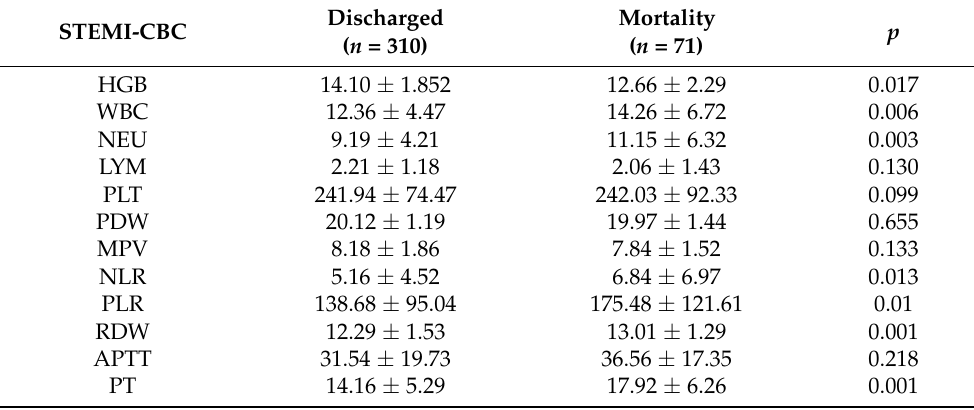
Table 3. Hematological and coagulation parameters of the mortality group vs. discharged group in STEMI